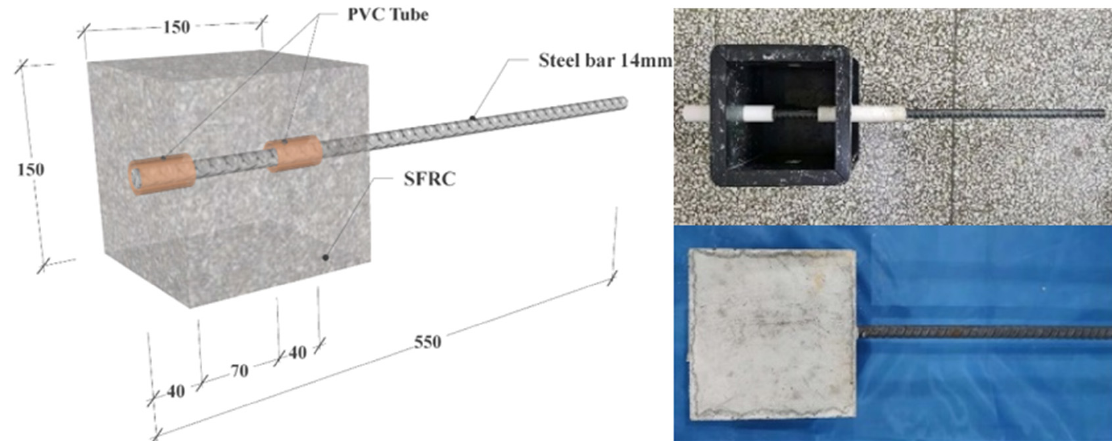
Figure 2. Specimen size and photograph (mm).